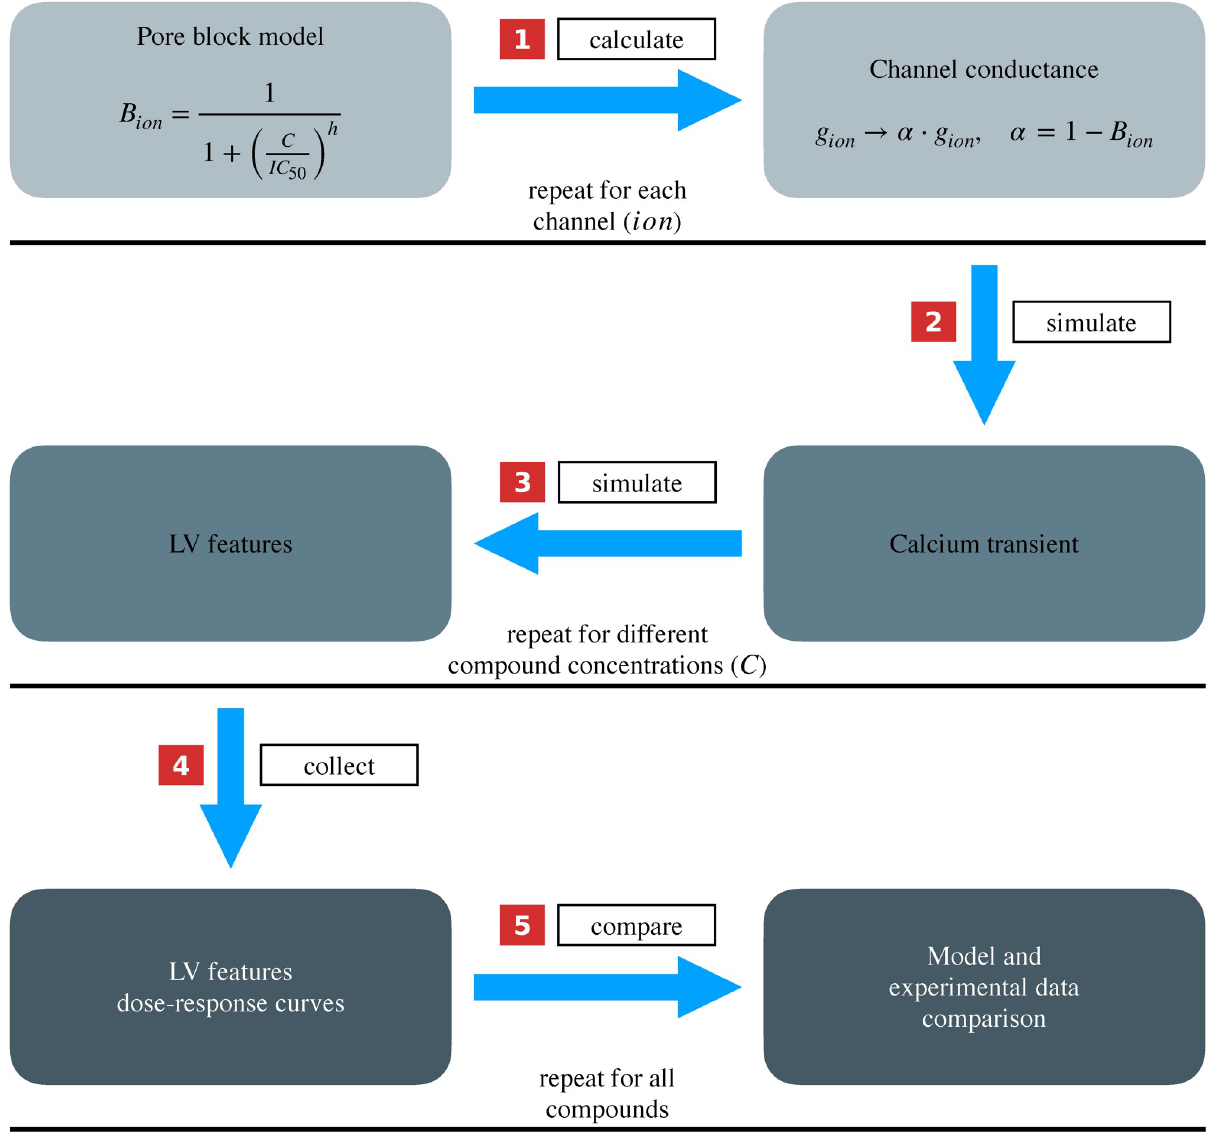
Fig 2. Model validation workflow. (1) The pore block model is used to calculate the fraction of blocked ion channel at a given compound concentration for each ion channel. These channels’ conductances are scaled to reflect the effect of the compound. (2) The rat myocyte electrophysiological model is run to generate perturbed calcium transients for different compound concentrations. (3) The calcium transients are used as an input for the 3D biventricular rat heart contraction model, and perturbed LV features’ values are obtained. For each LV feature, the number of perturbed values was equal to the number of input calcium curves, which corresponds to the number of tested compound concentrations. (4) Each LV feature values are plotted against the tested compound concentrations to obtain dose-response curves. (5) The qualitative trend of the LV features after in silico pharmacological modulation is compared with literature experimentally measured effects of the same compound on the same LV features for each compound under study.